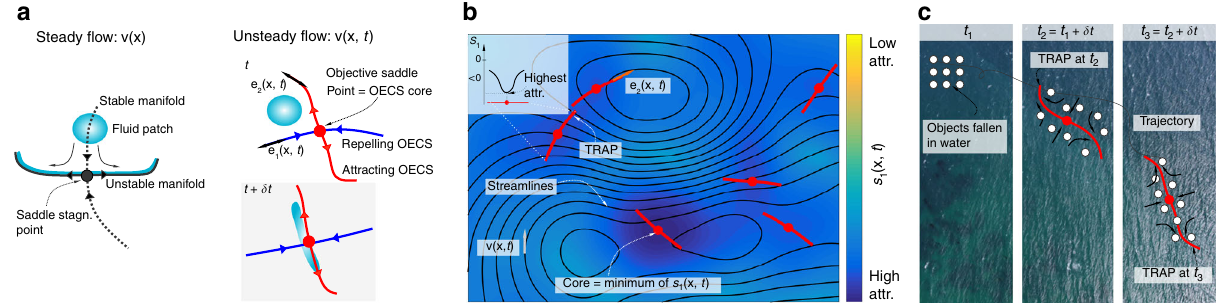
Fig. 2 Transient attracting pro fi les (TRAPs). a Deformation of a fl uid patch close to a saddle stagnation point in a steady fl ow (left), and to an objective saddle point in an unsteady fl ow (right). Over short times, a fl uid patch aligns with the repelling OECS, and squeezes along the attracting OECS, which both evolve over time. Attracting (Repelling) OECSs are everywhere tangent to the eigenvector fi eld e 2 ( e 1 ) of the rate-of-strain tensor, with their cores located at minima of the smallest eigenvalue s 1 . b Attracting OECSs, i.e. TRAPs, in an unsteady ocean velocity data set derived from satellite altimetry data along with their normal attraction rate s 1 encoded in the colorbar. TRAPs are hidden to instantaneous streamlines (black). c Illustration of a TRAP evolving in time and attracting within a few hours fl oating objects whose uncertain initial locations are represented by a square set of white dots.